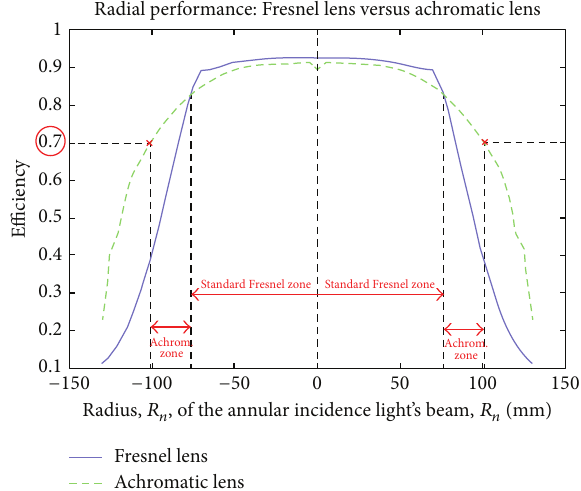
Figure 10: Efficiency of the achromatic lens versus annular inci- dence’s